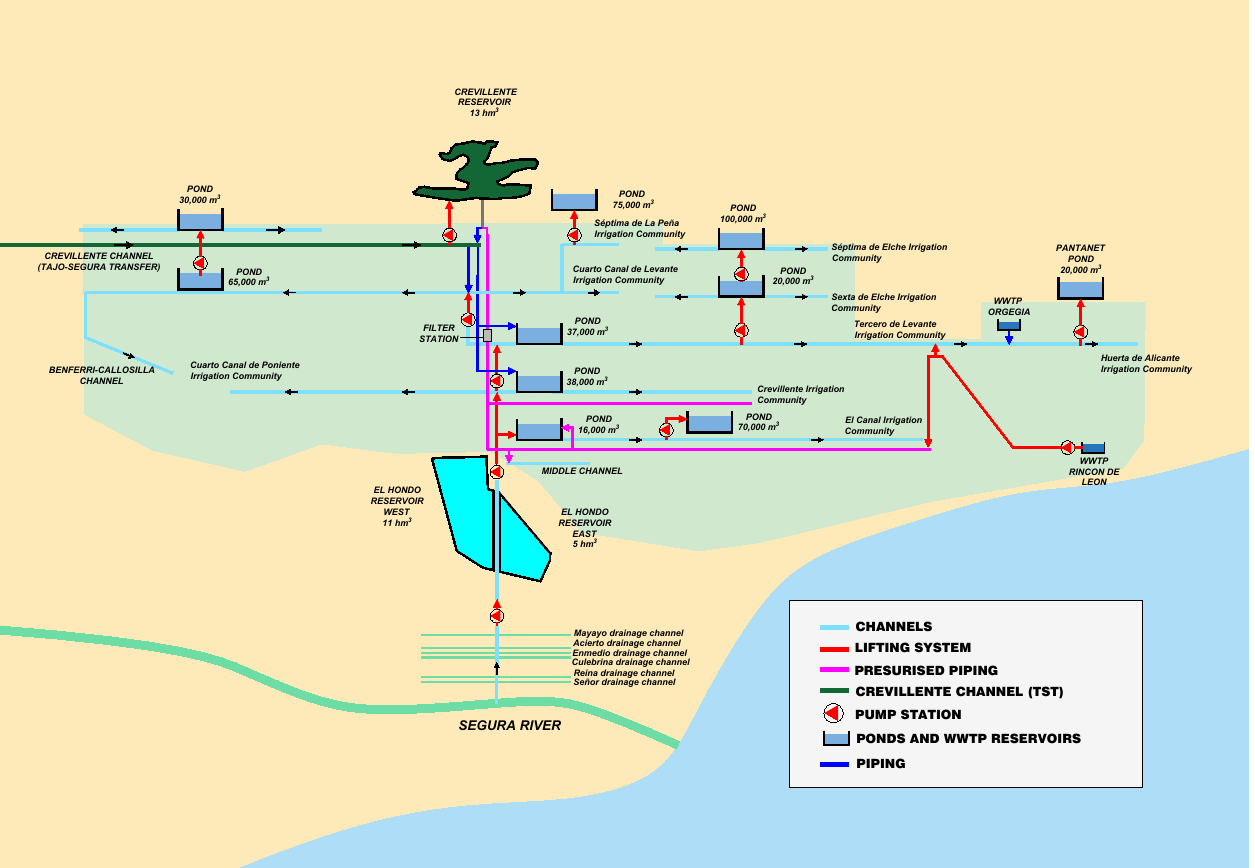
Figure 2. Hydraulic diagram of Riegos de Levante, Izquierda del